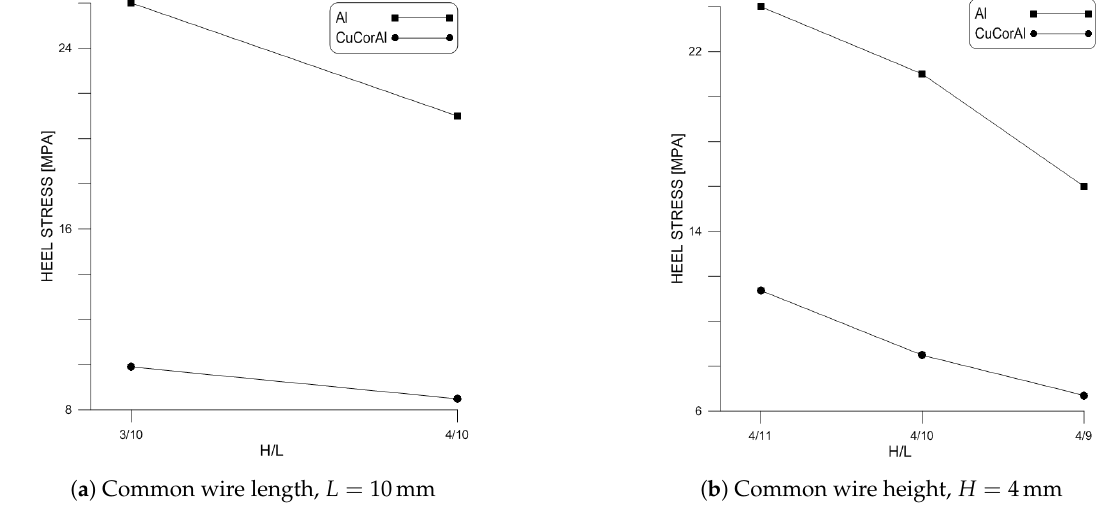
Figure 11. Comparison of critical stress in Al and CucorAl wires with identical